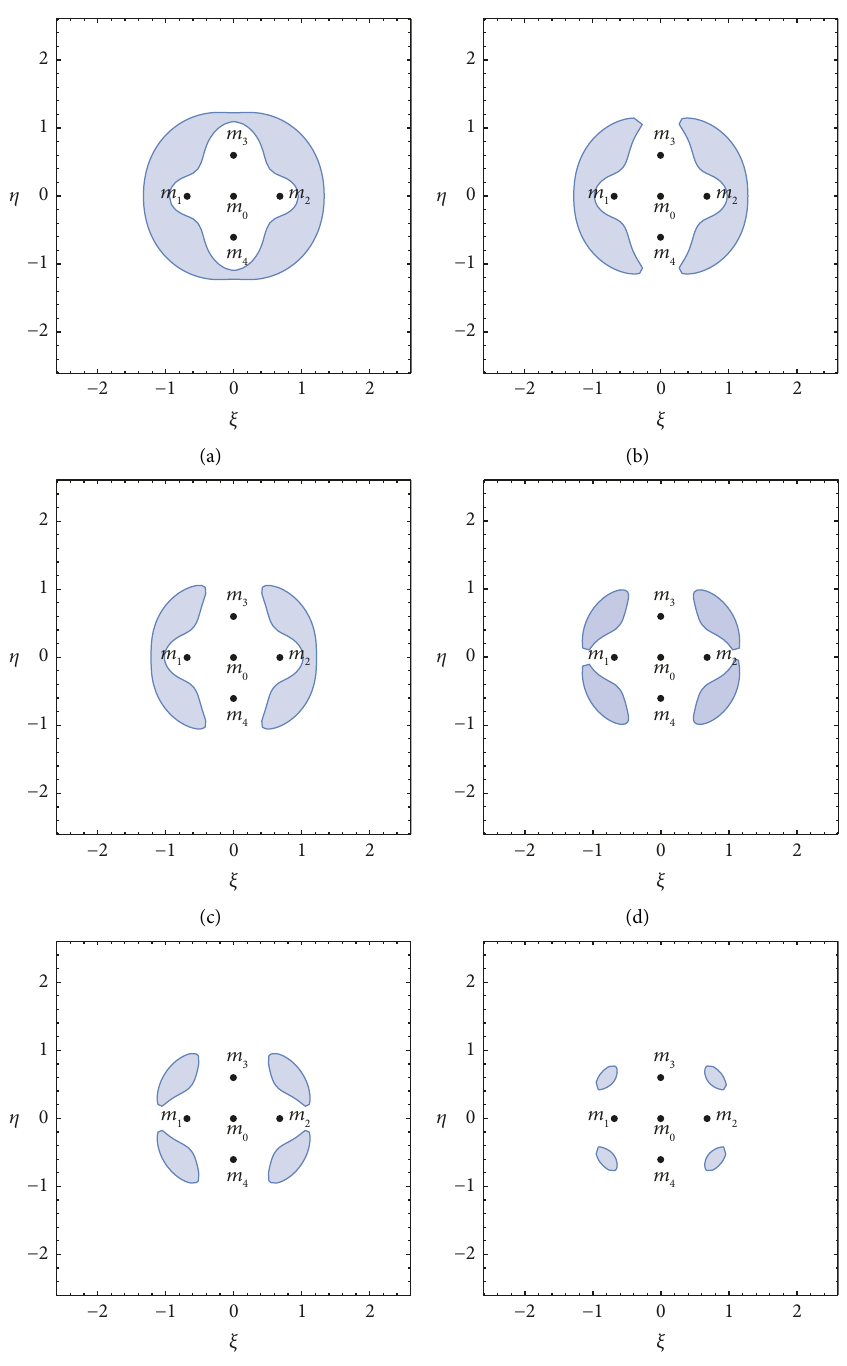
Figure 8: The permitted (white) and prohibited (shaded) regions of motion of m (a) C � − 1 . 66, (b) C � − 1 . 63, (c) C � − 1 . 60, (d) C � − 1 . 58, (e) C � − 1 . 57, and (f) C � − 1 .